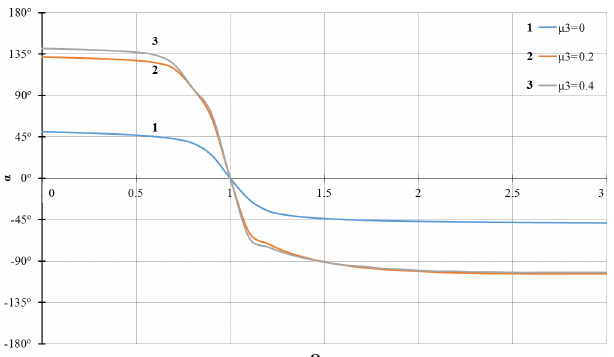
Figure 15. Dependence of the vibration phase α on the rotor speed (cid:127) with linear stiffness of the support and at value of the coefficient of linear viscous damping µ 1 = 0 . 1 and different values of the non- linear viscous damping coefficient µ 3 .